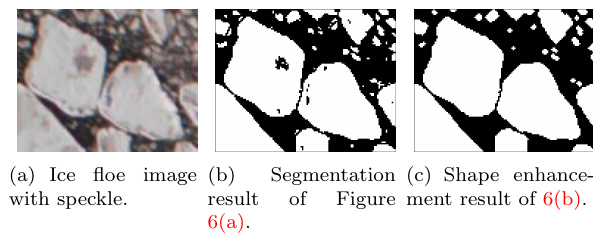
Figure 6: Ice shape enhancement.